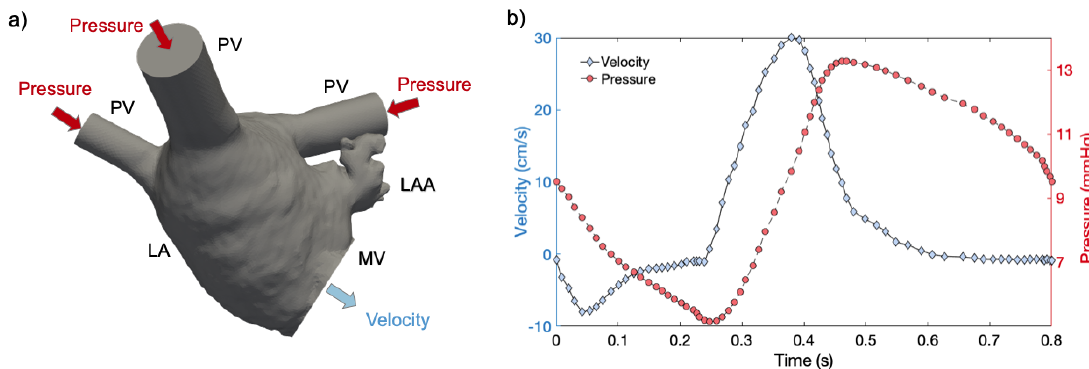
Figure 2. CFD model of LA with LAA, PVs and MV, including inflow pressure boundaries (marked in red) and velocity outflow boundary (marked in blue) ( a ). PVs inflow pressure and MV outflow velocity curves during cardiac cycle ( b